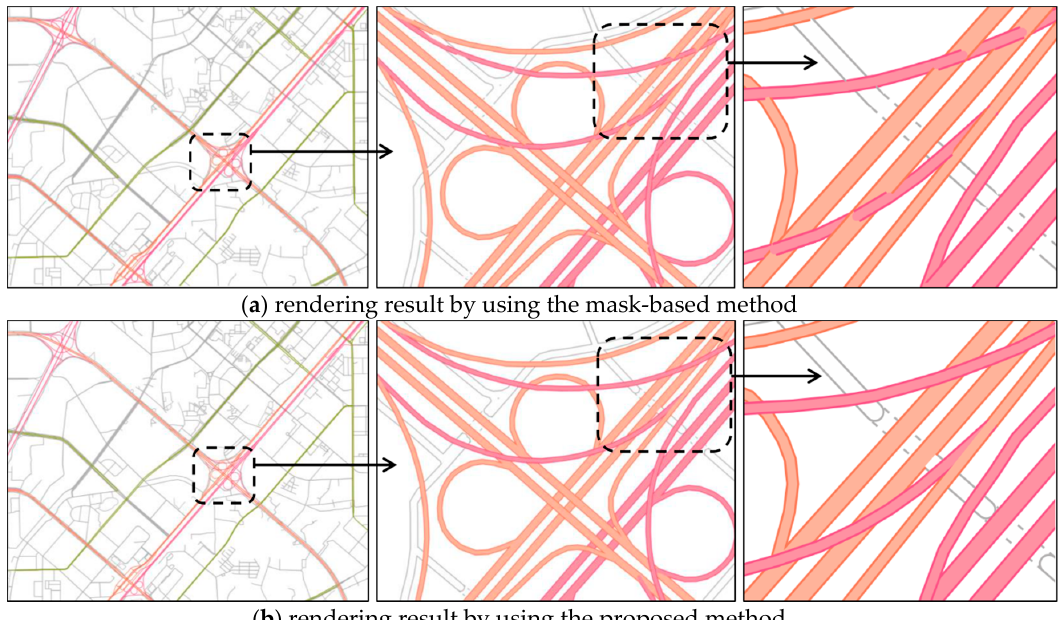
Figure 15. Rendering results for the first sample dataset.